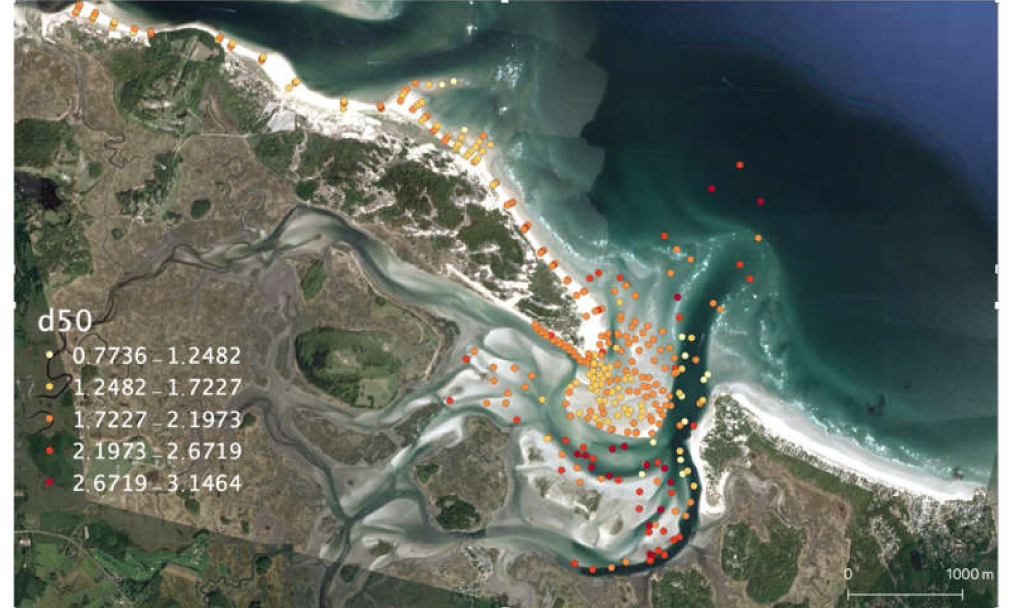
Figure 5. Grain-size trends along Castle Neck and at Essex Inlet (grain size in phi). Note the general decrease in grain size (increasing phi value) toward the inlet and into Essex Bay.